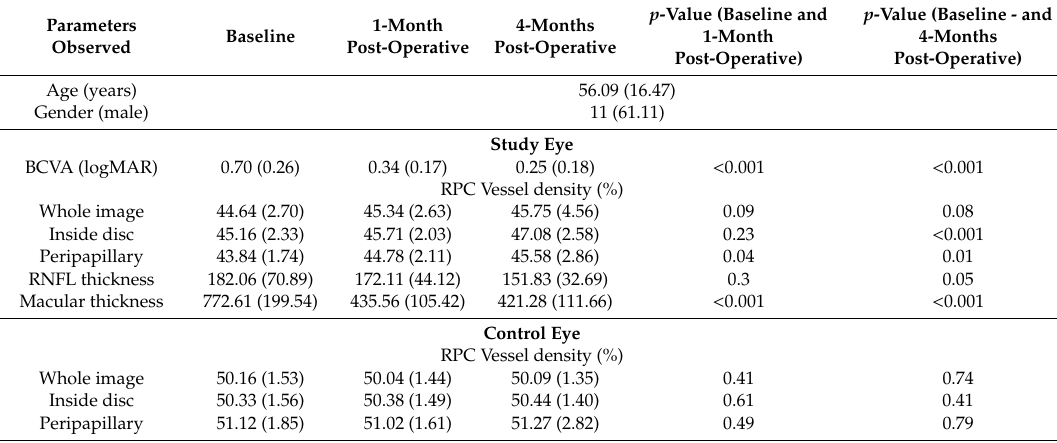
Figure 1. The optic nerve parameters acquired. Infrared image of the disc area ( A ). Optical Coherence Tomography (OCT) and Optical Coherence Tomography-Angiography (OCT-A) scans above outer plexiform layer ( B , D ) and between inner limiting membrane and nerve fiber layer ( C , E ). Inside disc Vessel Density (VD) ( F ), measured inside the optic disc boundary and peripapillary VD, calculated for the region of 750 µm-wide elliptical annulus extending from the optic disc boundary. Nerve fiber thickness map, including Retinal Nerve Fiber Layer (RNFL) ( G ). Table 1. Demographic characteristics and measurements at baseline, 1 and 4 months after ranibizumab intravitreal injection. T-test was performed to study continuous variables ( p -value refers to parameter changes). Abbreviations: BCVA = best corrected visual acuity; logMAR = logarithm of the minimal angle of resolution; RNFL = retinal nerve fiber layer; RPC = radial peripapillary capillary; VD = vessel density. Bold numbers indicate a p -value of less than